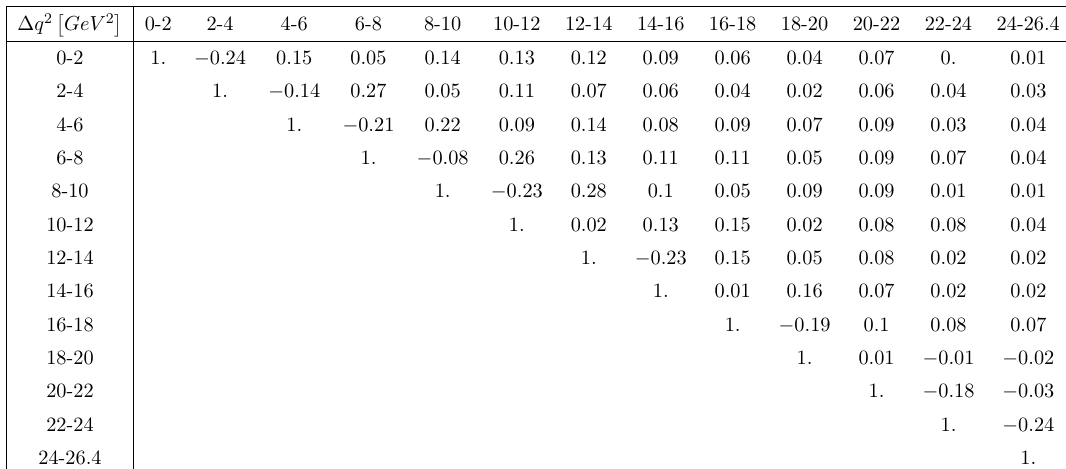
Table 13 . Correlation matrix of the q 2 average spectrum in our analysis. Corresponding to column three of table 1.